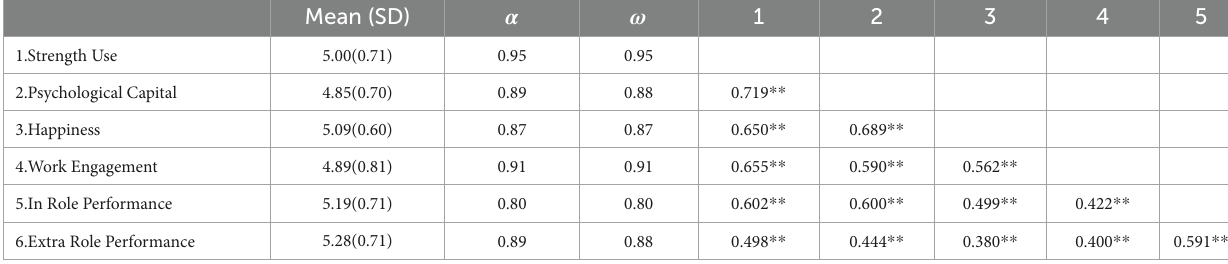
TABLE 1 Descriptive statistics, reliability coefficients, and Pearson’s correlations for all study 1